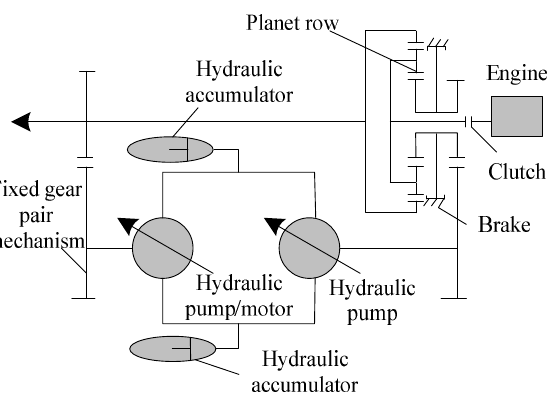
Figure 1. Overall model structure of the power system of the hydraulic hybrid electric vehicle.